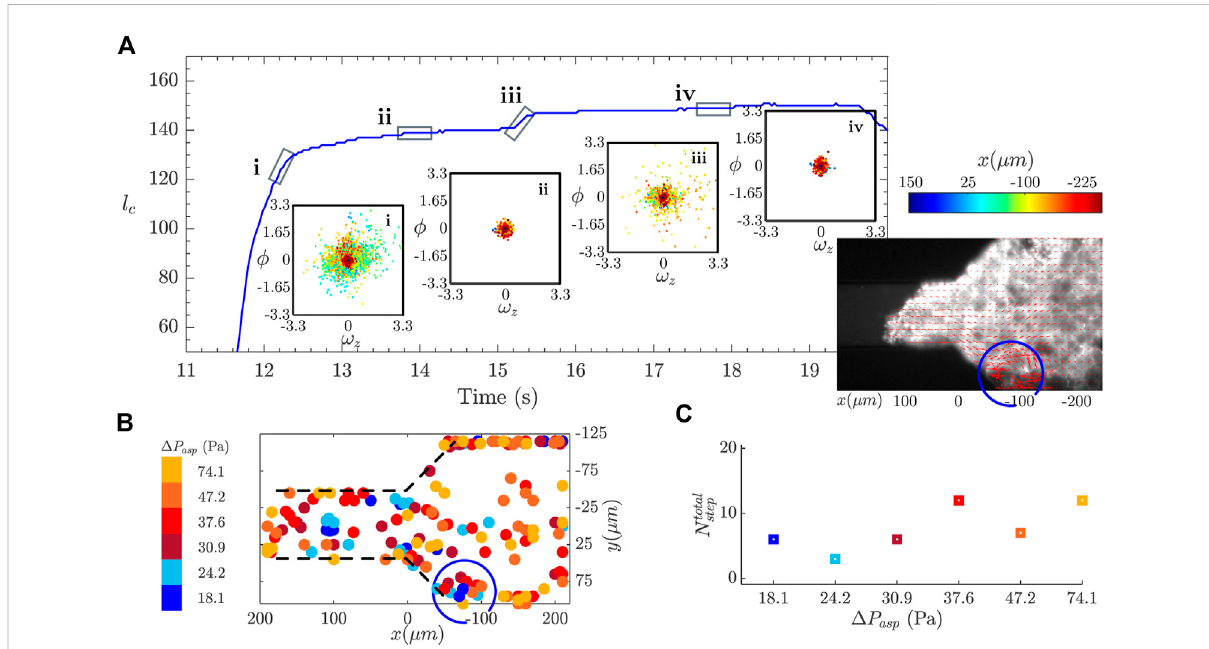
FIGURE 7 Detectionofreorganizationeventsduringthecreepexperiment. (A) Thebluecurveshowsthecontactlength, l c ,asfunctionoftime,duringone aspiration step. A γ -jump is visible on the curve at around 15.5 s. The graphs in the insets show the divergence, ϕ , versus the z -component of the vorticity, ω z , as a scatter plot, for different moments of the aspiration before and after the occurrence of the γ -jump. The color code refers to the position along the x axis ( fl ow direction). The image in the inset shows the overlay of the fl uorescence image with the vector representation of the velocity fi eld obtained with the PIV algorithm for the prototissue. (B) Localization of reorganization events obtained for the prototissue shown in (A). Different colors correspond to the events obtained for different aspiration pressures. (C) Representation of the total number of events detected for each aspiration